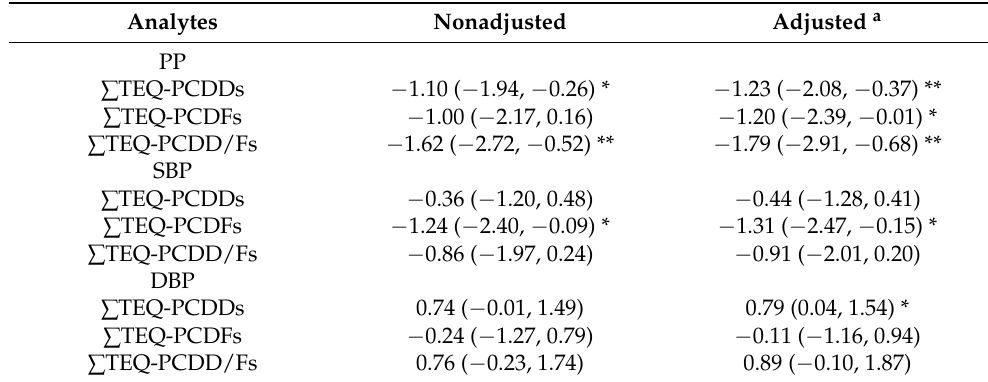
Table 4. Regression coefficients [ β (95% CI)] for BP associated with groups of ln-transformed TEQs in maternal serum ( n = 305).